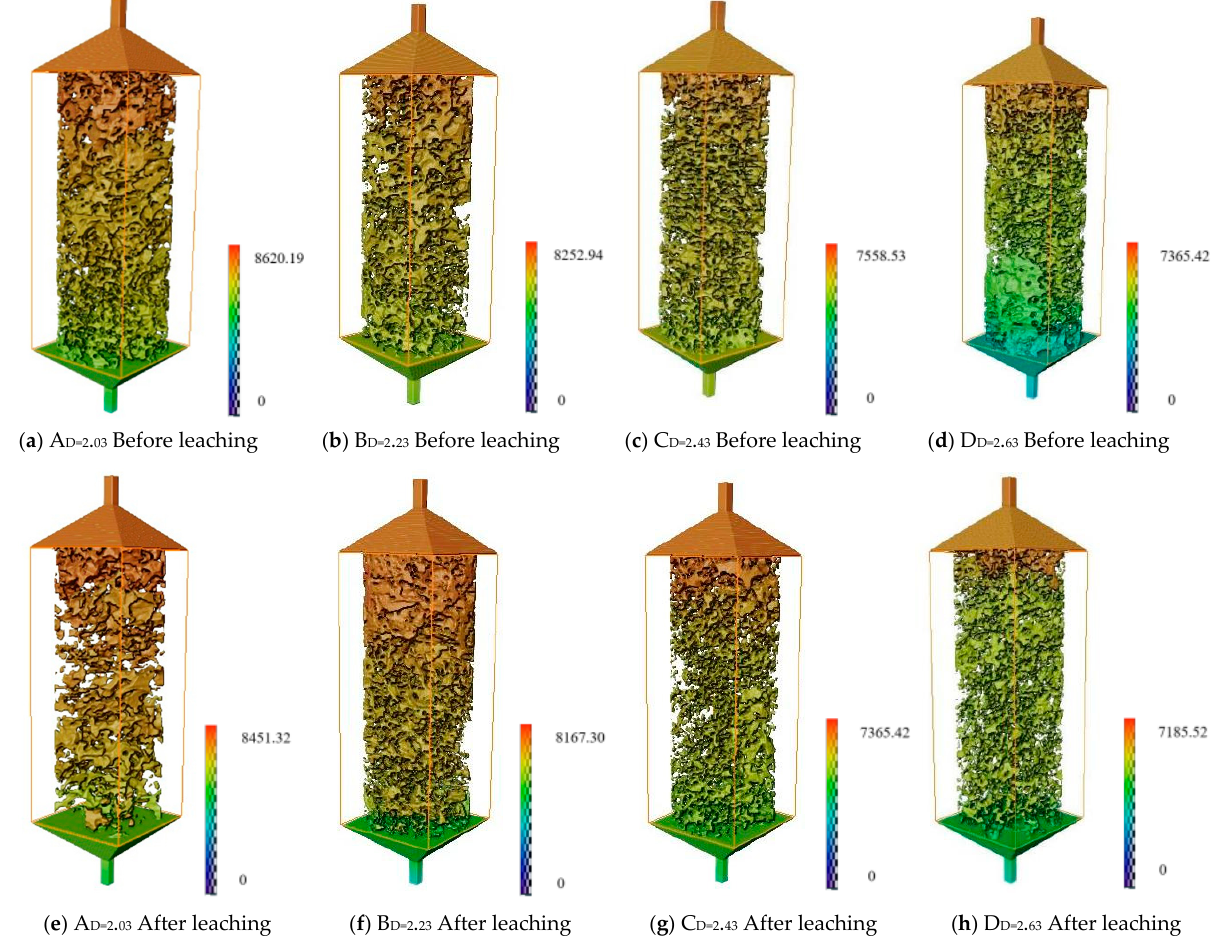
Figure 15. Distribution diagrams of pore pressure of ore samples. ( a ) A D = 2 . 03 Before leaching; ( b ) B D = 2 . 23 Before leaching; ( c ) C D = 2 . 43 Before leaching; ( d ) D D = 2 . 63 Before leaching; ( e ) A D = 2 . 03 After leaching; ( f ) B D = 2 . 23 After leaching; ( g ) C D = 2 . 43 After leaching; ( h ) D D = 2 . 63 After leaching. Table 3. Pore pressure of ore samples at di ff erent depths after leaching.